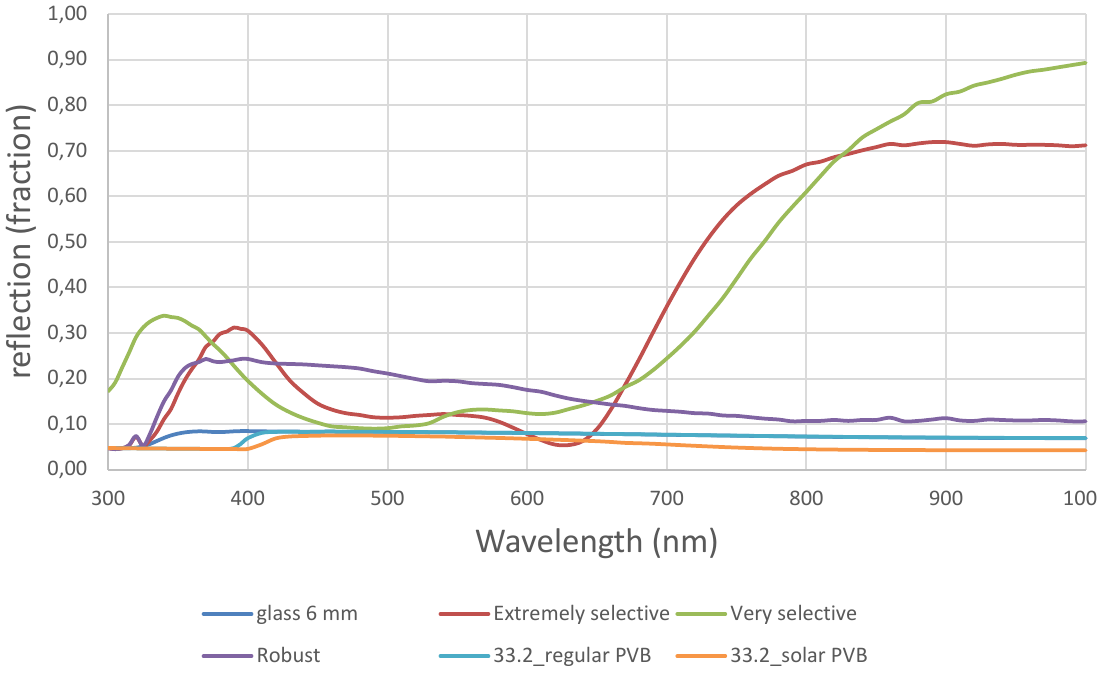
Fig. 2. Spectral performance of nominally 6 mm glass configurations as indicated (glass, coated glass (three coating types) laminated glass (two interlayer types),